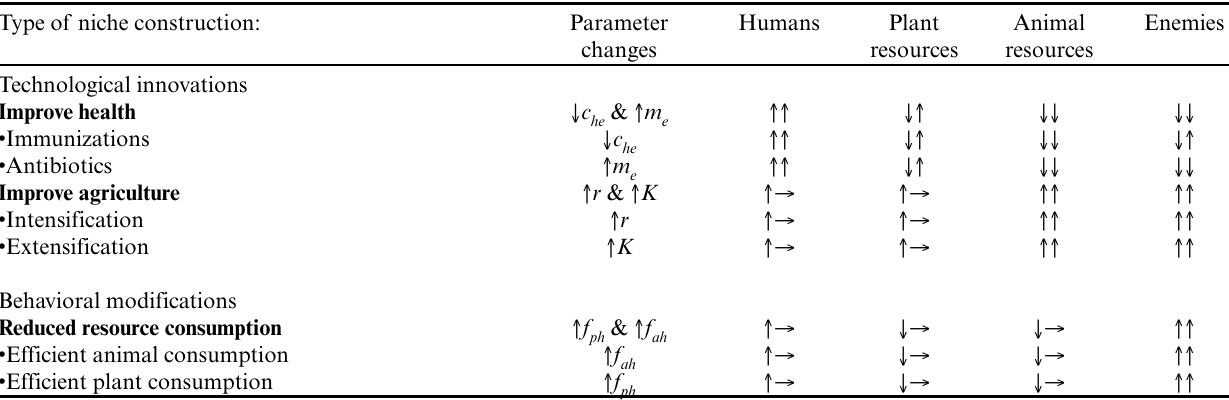
Table 2 . Effects of human ecological niche construction on abundances of humans, plant and animal resources, and natural enemies. The first arrows indicate initial transient effects; the second arrows indicate long-term effects on equilibrium abundances. For example, improving agriculture (by increasing r and K in our model) initially increases human population ( ↑ ), but has no long-term effect on human population ( →